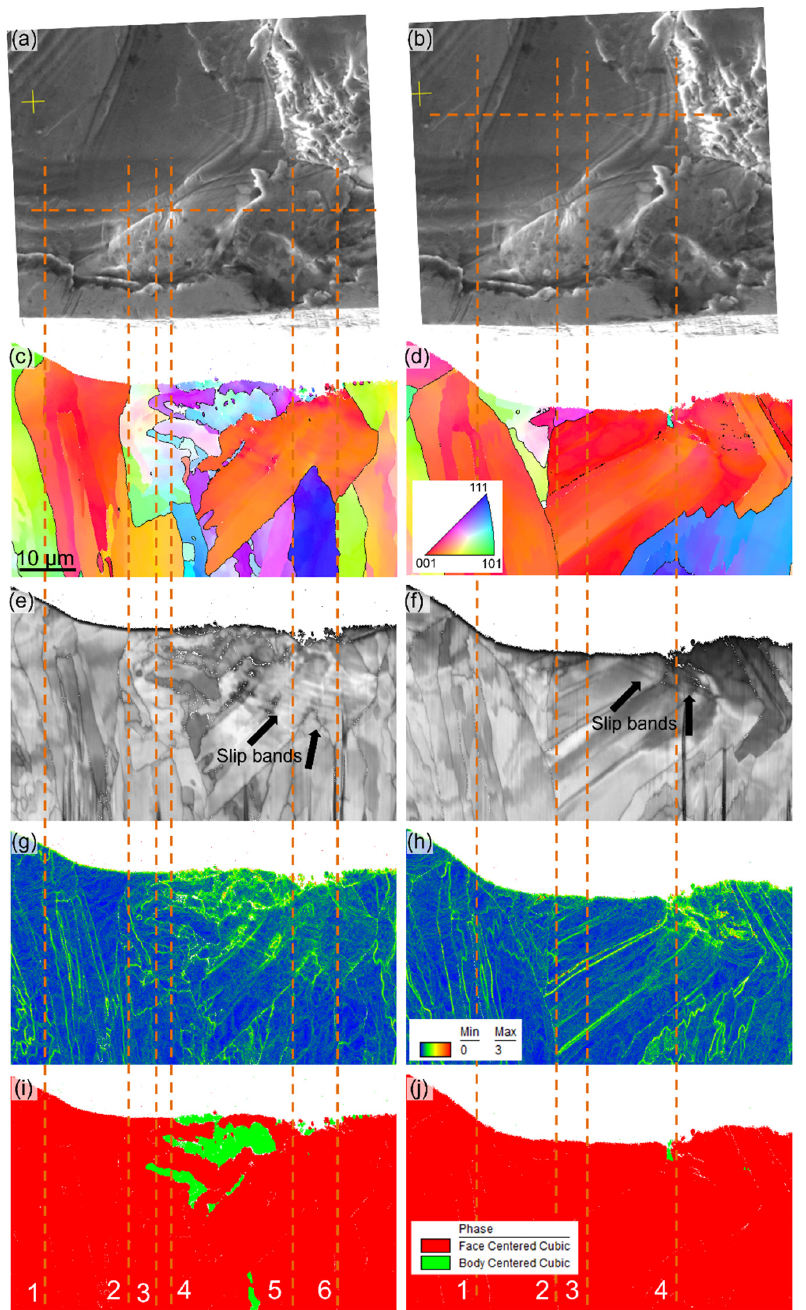
Figure 4. ( a , b ) SEM top view images of the LOF defect and its surrounding microstructure (orange horizontal lines show the position of the cross section). ( c , d ) Inverse pole figure maps showing the grain structure. ( e , f ) Image quality maps showing intragrain orientation gradients and slip bands. ( g , h ) Kernel average misorientation maps showing local deformation and subgrain boundaries. ( i , j ) Phase maps showing austenite (red) and α ’-martensite (green). Note that ( c – j ) show cross-sectional views with the crack surface located perpendicular at the upper edge of the images. The lines 1 to 6 indicate the location of the microstructure in the cross-sectional views in relation to the fracture